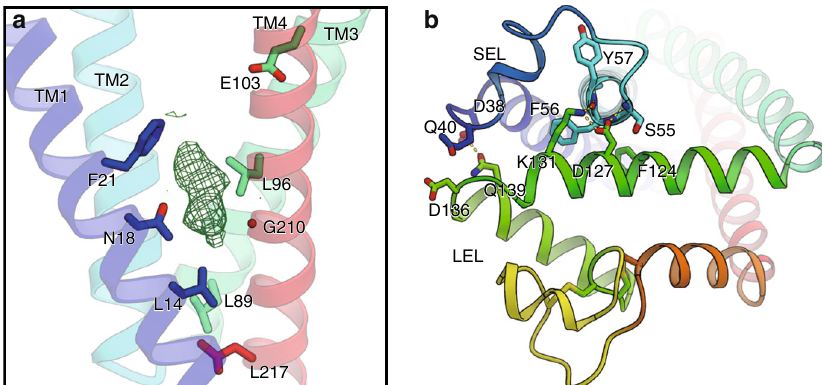
Fig. 2 Central hydrophilic pocket and extracellular loops. a The central cavity is rendered hydrophilic by the conserved residues, Asn18 and Glu103. The critical residue for cholesterol binding, Glu219 in CD81, is replaced by Gly210 in CD9 (Supplementary Fig. 1). The F o − F c map contoured at 2.5 sigma shows an unknown density within the cavity, probably derived from the monoolein present during the lipidic cubic phase crystallization. b The central cavity is sealed on the extracellular side by the association between the SEL and LEL. The residues involved in the interactions are shown, and the hydrogen bonding interactions are indicated by yellow dotted lines.